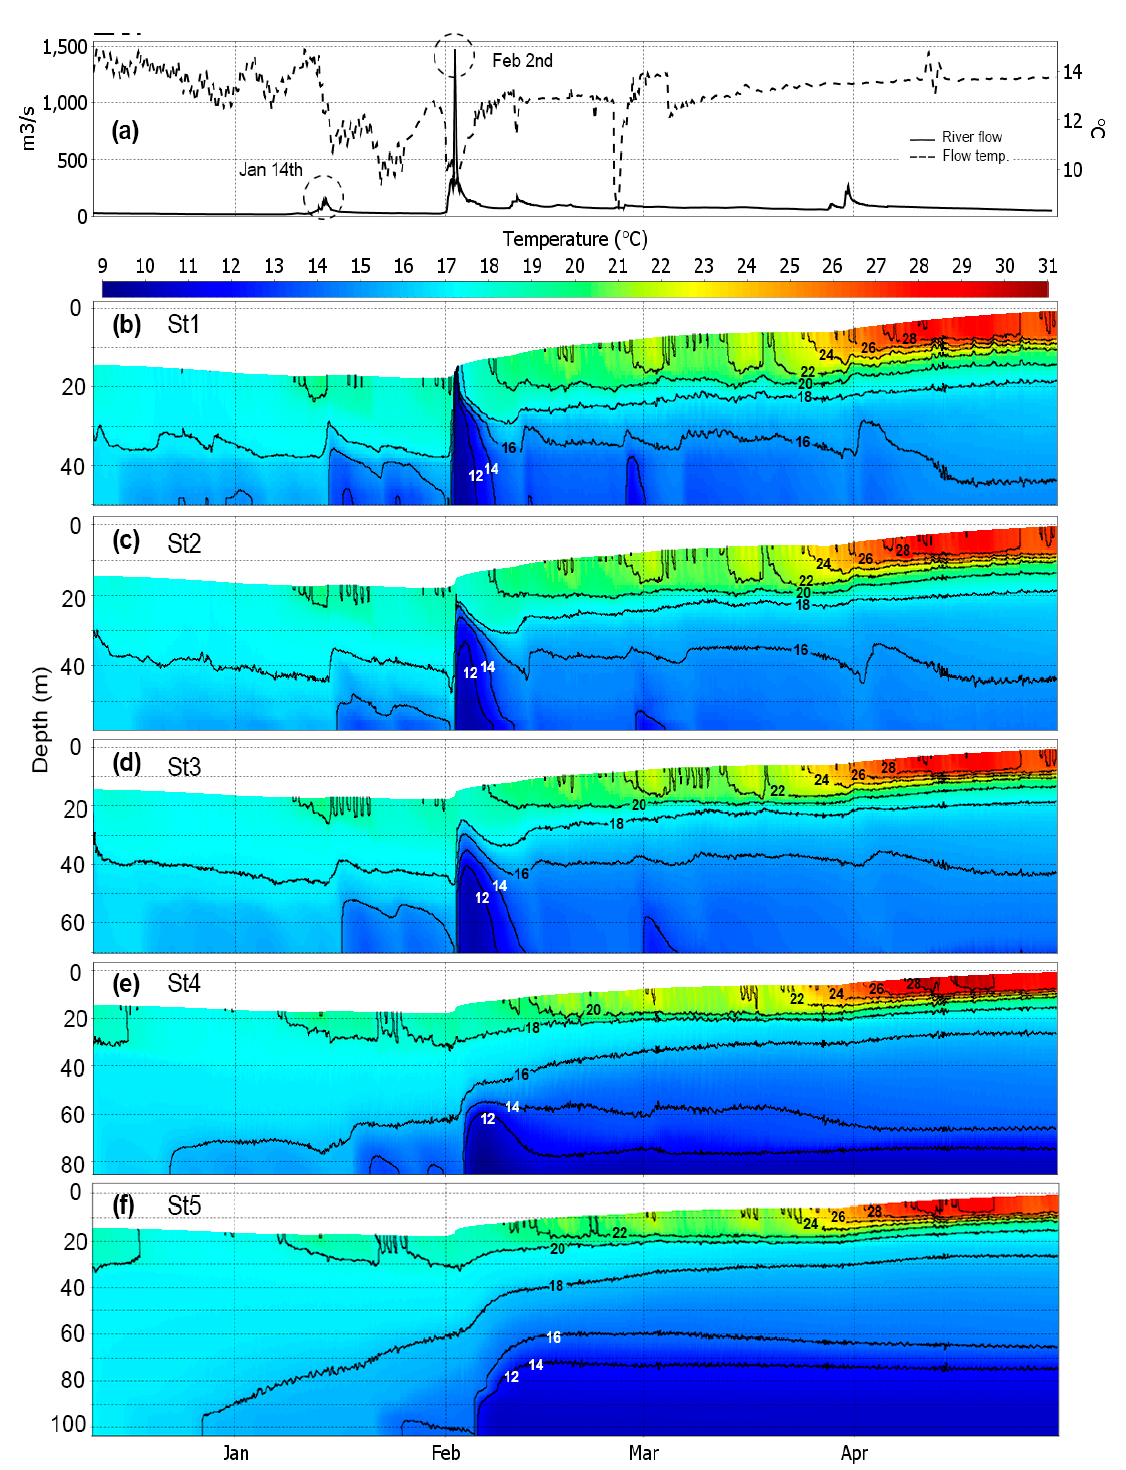
Figure 10. ( a ) River flow rate (continuous line) and temperature (dashed line) in the Maroon Reservoir; ( b–f ) temporal variation of AEM3D-simulated water column temperatures at the various measurement